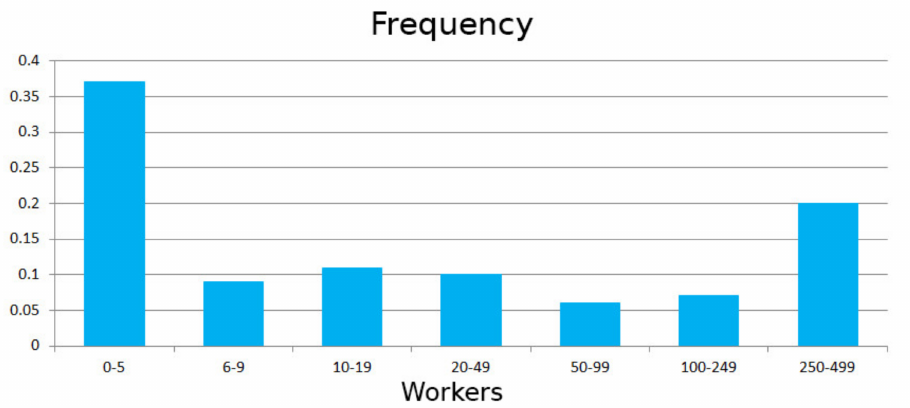
Figure 7. Distribution of work